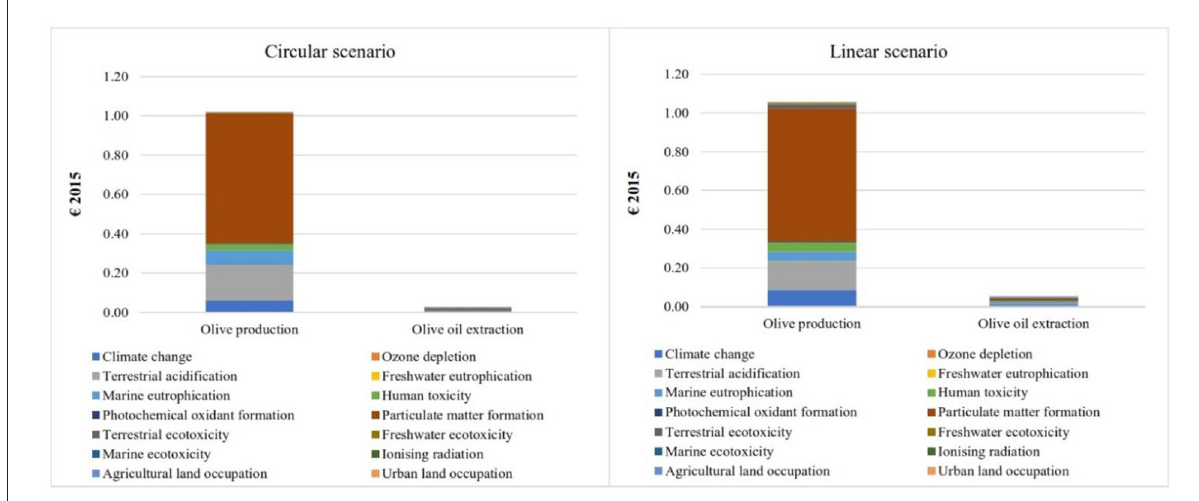
FIGURE4 Environmental cost contribution analysis (Source: Authors’ elaboration).